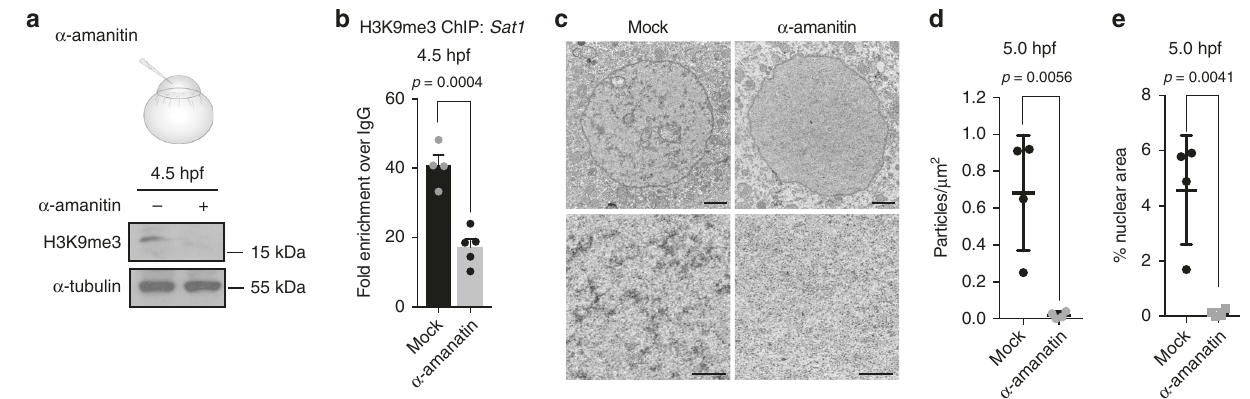
Fig. 3 Blocking zygotic transcription impairs heterochromatin. a Western blot for H3K9me3 (top) and α -tubulin (bottom) using protein extracted from embryos that were either mock injected ( − ) or injected with 0.2 ng of α -amanitin ( + ) at the one-cell stage. Protein was collected for analysis at 4.5 h post fertilization (hpf). b Chromatin immunoprecipitation with sequencing (ChIP) for H3K9me3 enrichment at pericentromeric Satellite-1 (Sat1) repeats in wild- type and α -amanatin-injected embryos. Embryos were collected for analysis at 4.5 hpf. P values were calculated using the Student ’ s t test; error bars indicate SEM. c Transmission electron microscopy (TEM) images demonstrating a lack of condensed chromatin ultrastructure in 5.0 hpf embryos that were injected with α -amanatin at the one-cell stage. Bottom panels represent higher magni fi cation images (×20,000) of nuclear interior in mock- and α - amanatin-injected embryos at speci fi ed time points. Scale bars indicate 1 μ m. d , e Quanti fi cation of the number of electron-dense aggregates per nuclear μ m 2 ( d ) and percent nuclear area covered by aggregates ( e ) in mock- and α -amanitin-injected embryos at 5.0 hpf. Particles/ μ m 2 and percent nuclear area were measured in nuclei from each of four α -amanitin- and four mock-injected embryos. Each graphed data point represents data from one embryo; values for each embryo are the average of six to ten representative nuclei. Error bars indicate SD. Source data for panel a is provided as a source data fi le